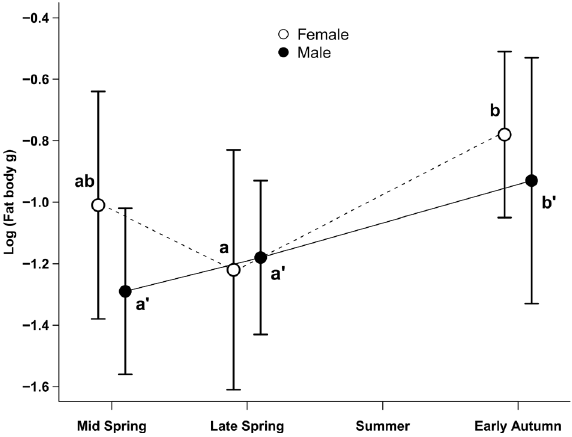
Figure 6. Seasonal variation of fat body weight [Log (Fat body g)] in adult females and males of Phymaturus extrilidus . Mean ± standard deviation is represented by empty dots and mustaches for females, and black dots and mustaches for males. Different lowercase letters indicate significant differences according to Post Hoc